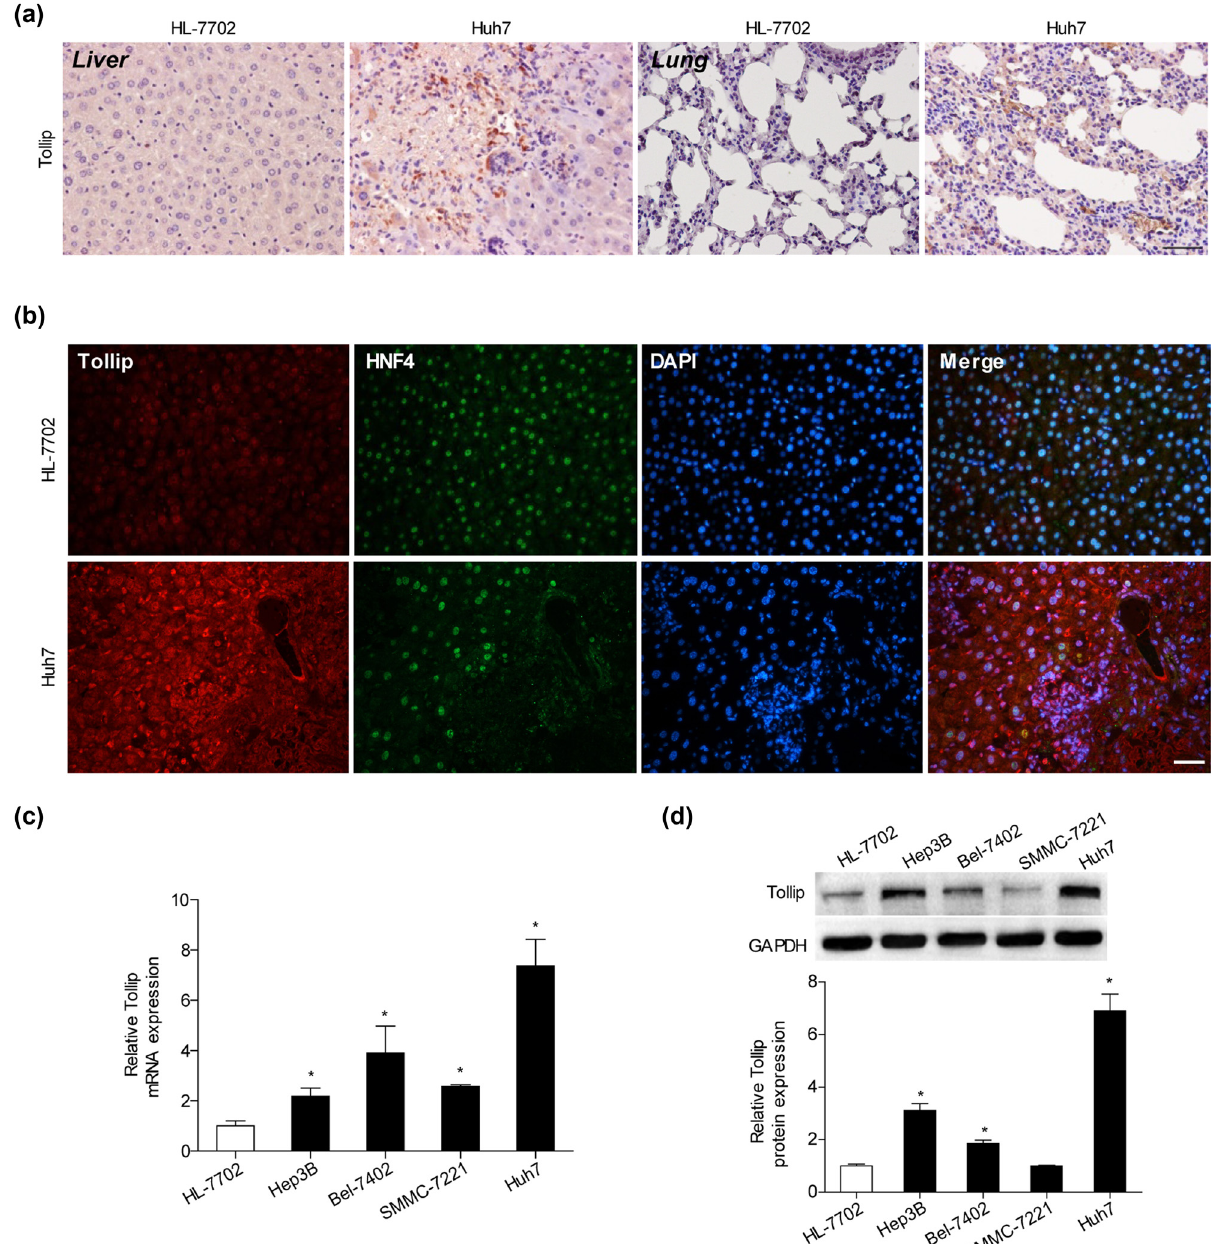
Figure 1: Upregulation of Tollip expression in HCC. ( a ) The expression of Tollip in HCC and lung tissues of BABL/c nude mice following subcutaneous injection of HL - 7702 or Huh7 tested by immunochemistry staining. Scale bar = 50 µm. n = 5 – 10 fi elds per experimental group. ( b ) The immuno fl uorescence staining shows Tollip ( red ) expression and localized in hepatocyte identi fi ed by HNF4 ( green ) of liver tissues from BABL/c nude mice following subcutaneous injection of HL - 7702 or Huh7. Scale bar = 50 µm. n = 6 – 8 fi elds per experimental group. ( c and d ) The expression of Tollip mRNA or protein level tested by RT - PCR or protein in HCC cell lines. n = 3 independent experiments. * p < 0.05 compared with control